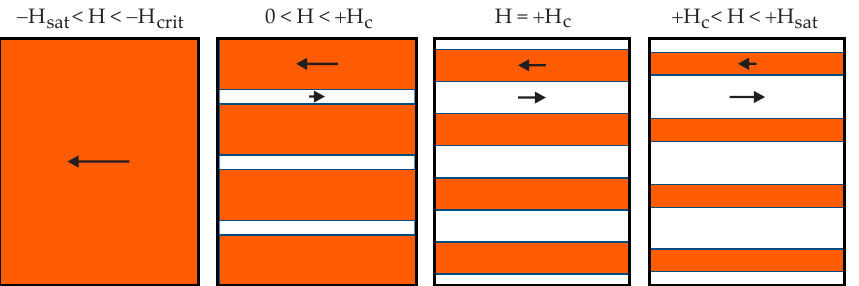
Figure 7. Schematic illustration of the stripe domain pattern of the coupled Py layer for increasing magnetic field, starting at negative saturation, − H sat , and increasing in the positive direction up to + H c < H < + H sat . Black arrows indicate the direction of the x -component of the in-plane magnetization m x in the coupled Py layer, whereas their length is proportional to the magnitude of m x inside the stripe domains. The change of the width of the stripe domains in the direction perpendicular to H dc is, however, largely exaggerated and in reality only very small.